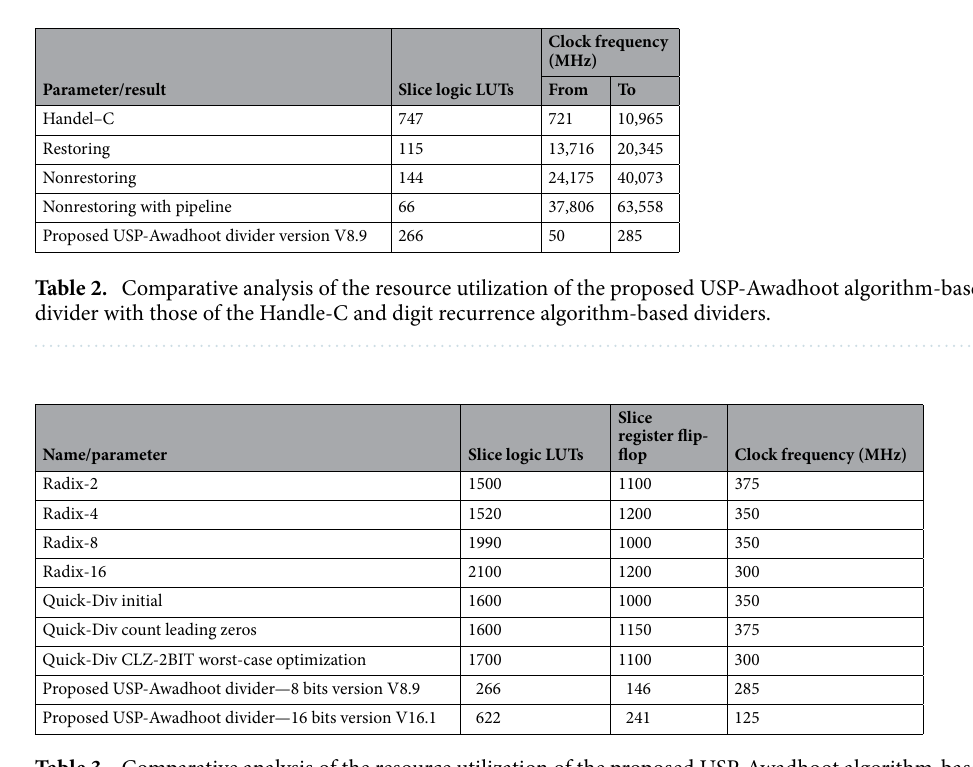
Table 3. Comparative analysis of the resource utilization of the proposed USP-Awadhoot algorithm-based divider with variable-latency Quick-Div dividers and fixed-latency radix-n